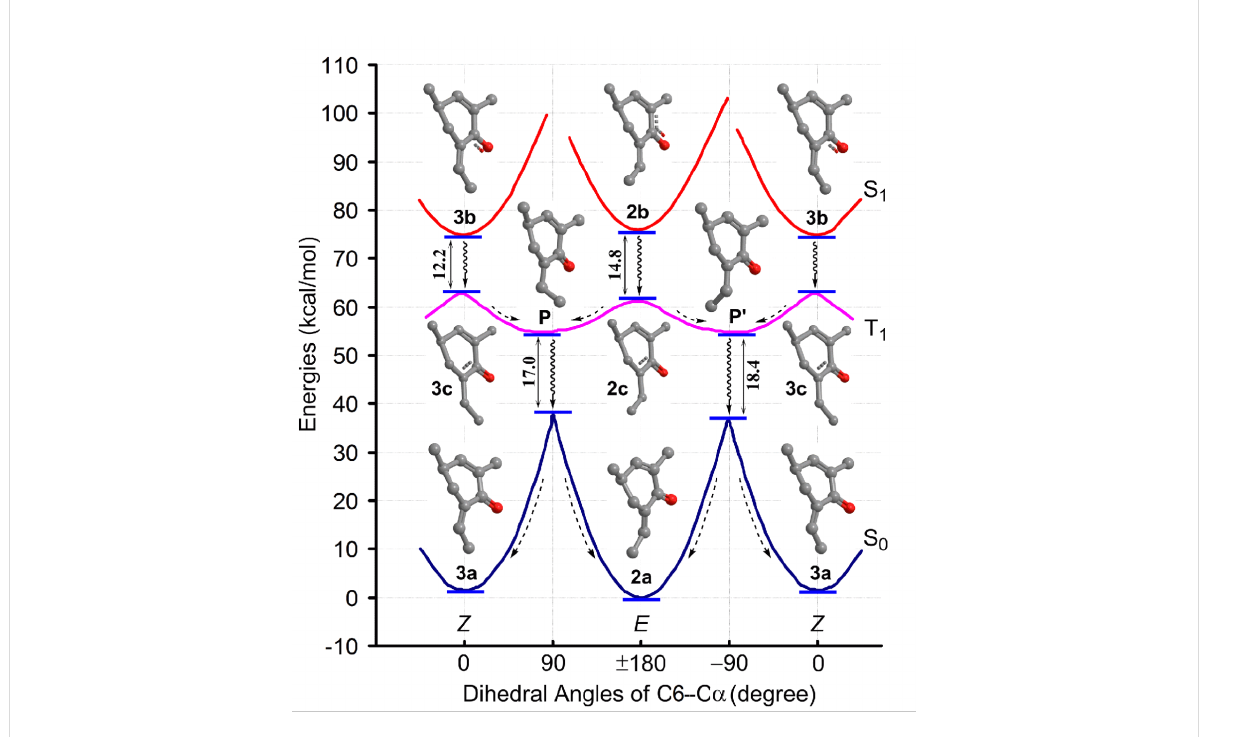
Figure 6: Potential energy surfaces of 2a / 3a in the S 0 , S 1 , and T 1 states, geometries of key points in the surfaces, and proposed photoreaction path (dashed arrow: vibrational relaxation; wavy arrow: ISC; double headed arrow: energy gap between the two points).